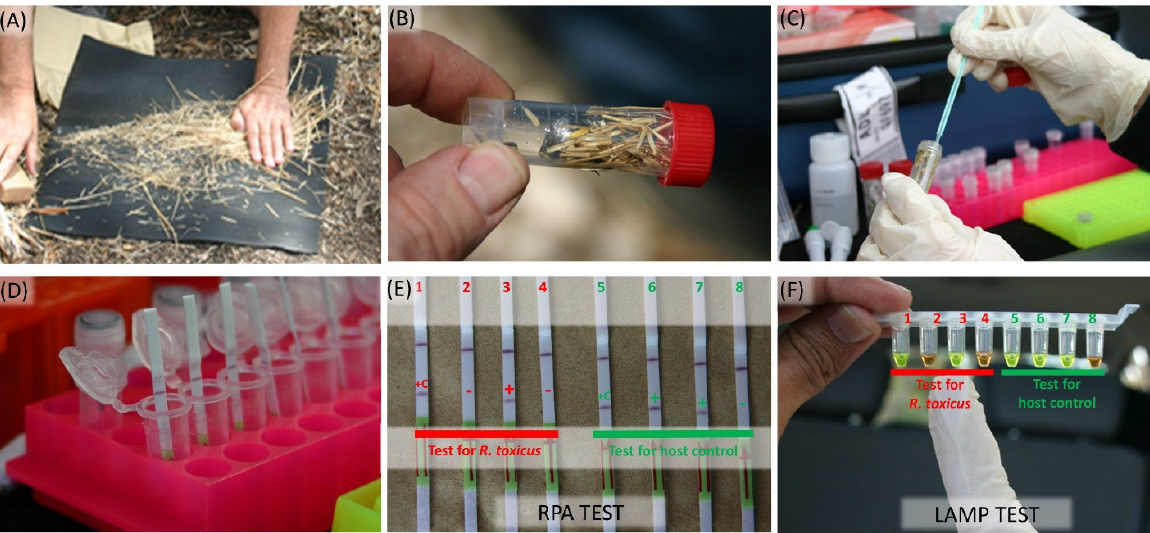
Figure 7. In-field detection of Rathayibacter toxicus from cultivated and non-cultivated annual ryegrass ( Lolium rigidum ) plants using a validated recombinase polymerase amplification (RPA) assay and a R. toxicus -specific loop mediated isothermal amplification (LAMP) assay: ( A ) annual ryegrass seeds were separated from plants; ( B ) samples were processed (OptiGene Plant Lysis Kit); ( C ) seed extract (one loopful, ca. 10 μ L) was transferred into a 1.0 mL OptiGene tube with buffer; ( D ) post-reaction, lateral flow strips (LFDs) were placed in a 500 μ L buffer (400 μ L water + 100 μ L buffer provided with the kit) containing 2 μ L of RPA amplified product; ( E ) RPA reaction products visualized with LFD; ( F ) RPA reaction products visualized with LAMP assay—there was no discrepancy between the RPA and LAMP results.